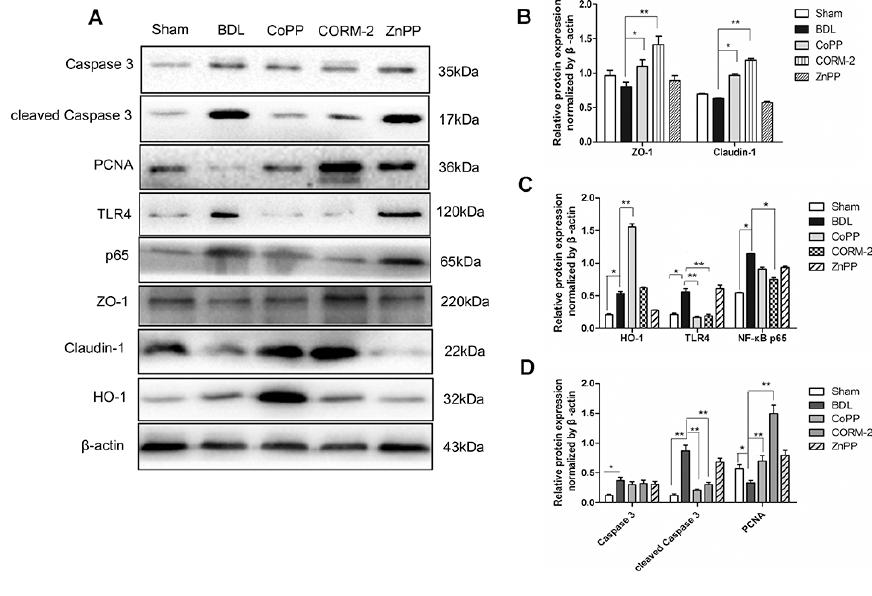
Figure 2. Effects of CoPP and CORM-2 on tight junctions, cell apoptosis, PCNA and TLR4/NF- κ B expression in intestinal tissue from Sham/BDL rats. (A) Western blot images; (B) the relative expression of ZO-1 and occludin. The expression levels of the TJ proteins ZO-1 and claudin-1 expression were significantly increased in the CoPP and CORM-2 groups compared with the BDL group; (C) HO-1, TLR4 and NF- κ B p65 were notably increased in BDL group compared with the Sham; (D) caspase 3, cleaved caspase 3 and PCNA ex- pression. Data are presented as the mean ± SD from three independent experiments, * P < 0.05, ** P < 0.01.